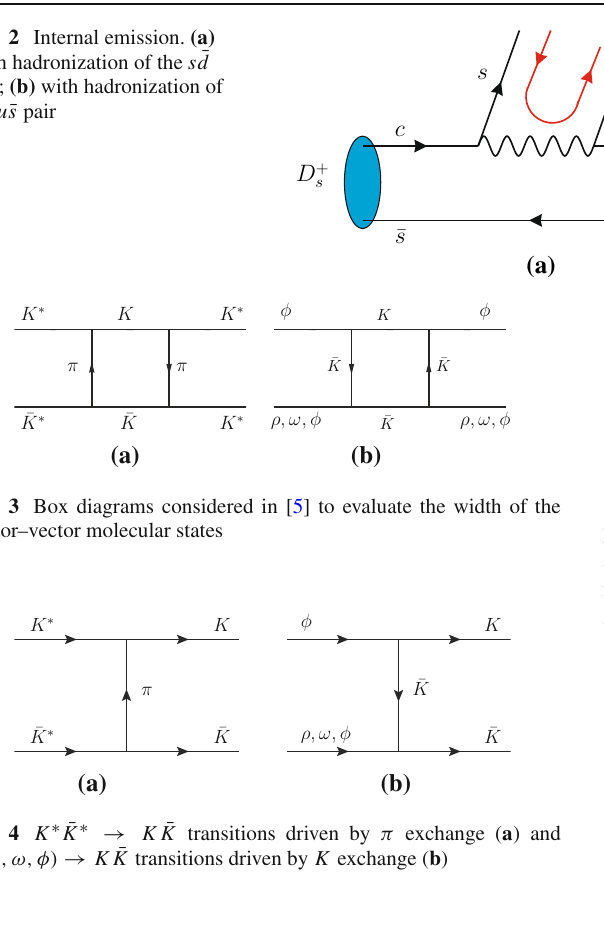
Fig. 2 Internal emission. (a)